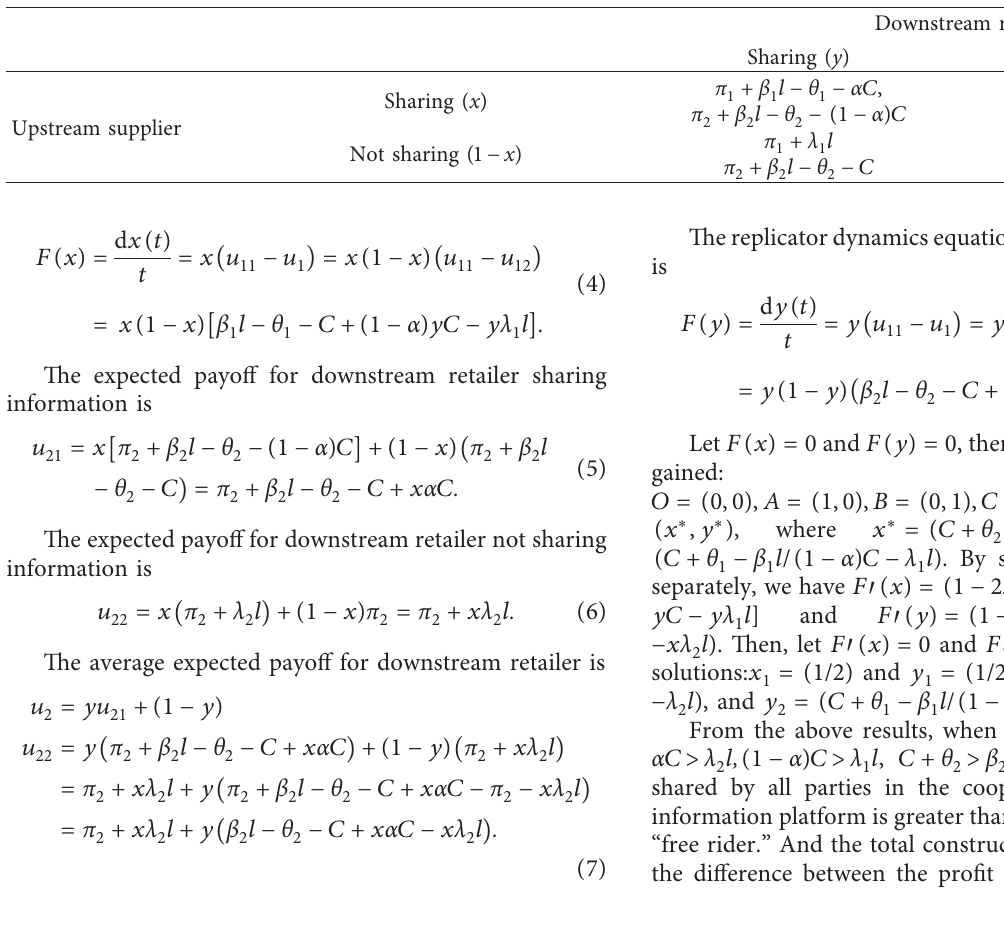
Table 2: Information sharing evolutionary game payoff